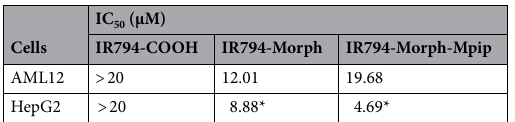
Table 2. IC 50 of IR794 treated with AML12 and HepG2 cells for 6 h.